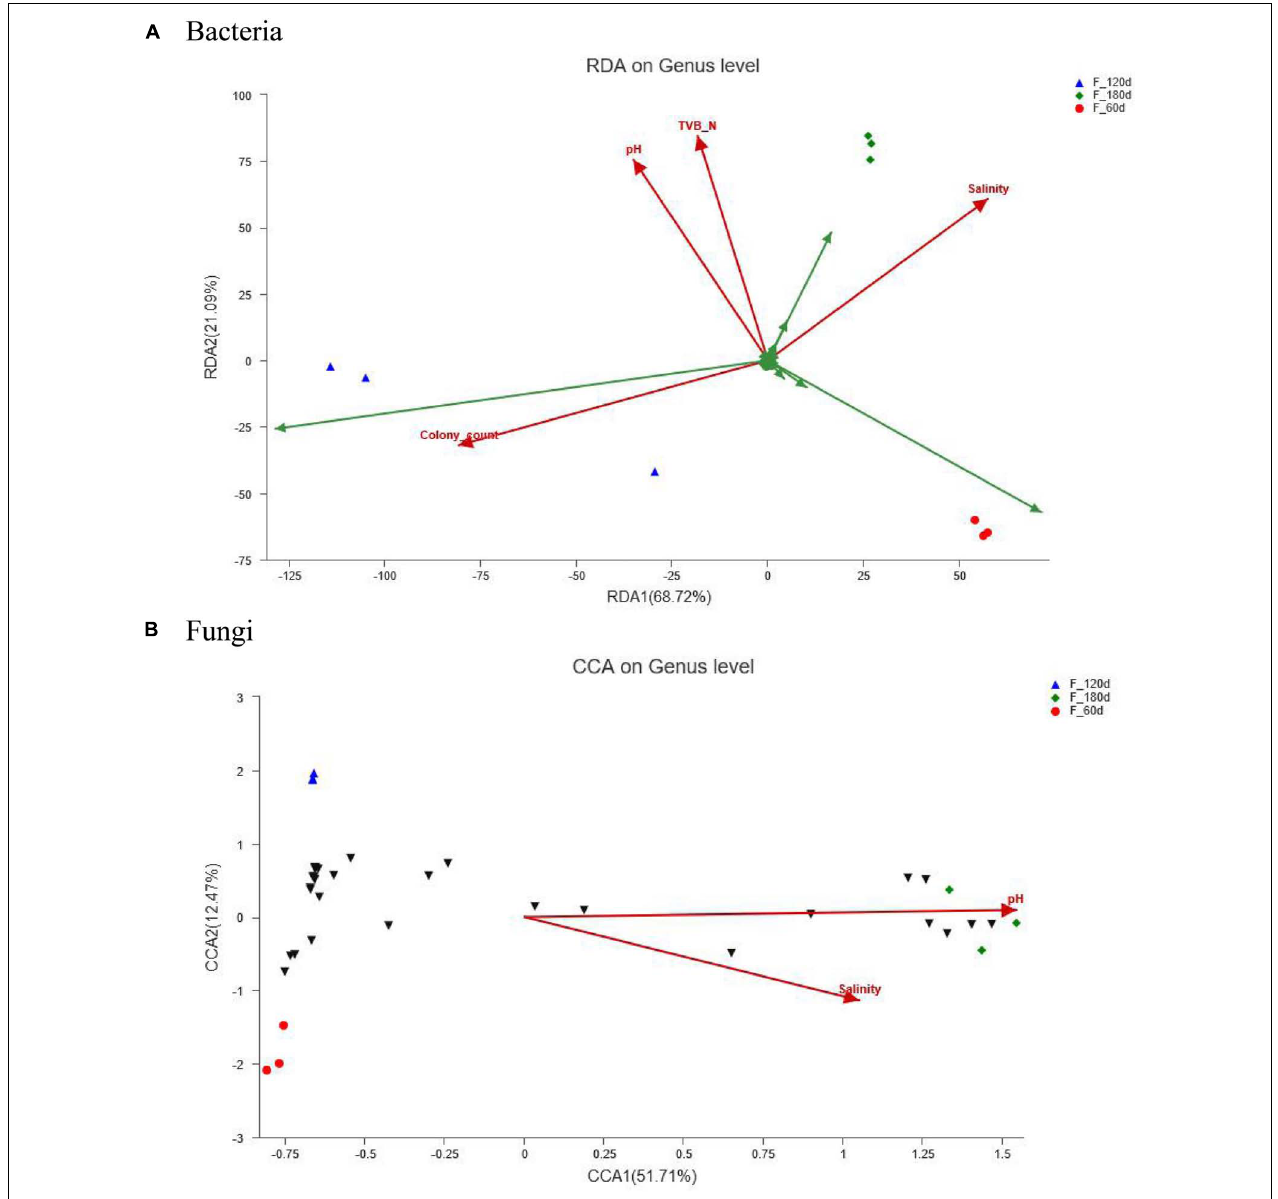
FIGURE 4 | RDA/CCA analysis of samples, microbial communities and physicochemical indexes: (A) Bacteria, (B) Fungi. Red arrows represent quantitative environmental factors, the length of which can represent the degree of impact of environmental factors on the distribution of species with the microbial communities; the angle represents correlation (acute angle: positive correlation, the smaller the angle, the greater the correlation; obtuse angle: negative correlation, the bigger the angle, the greater the correlation; right angle: no